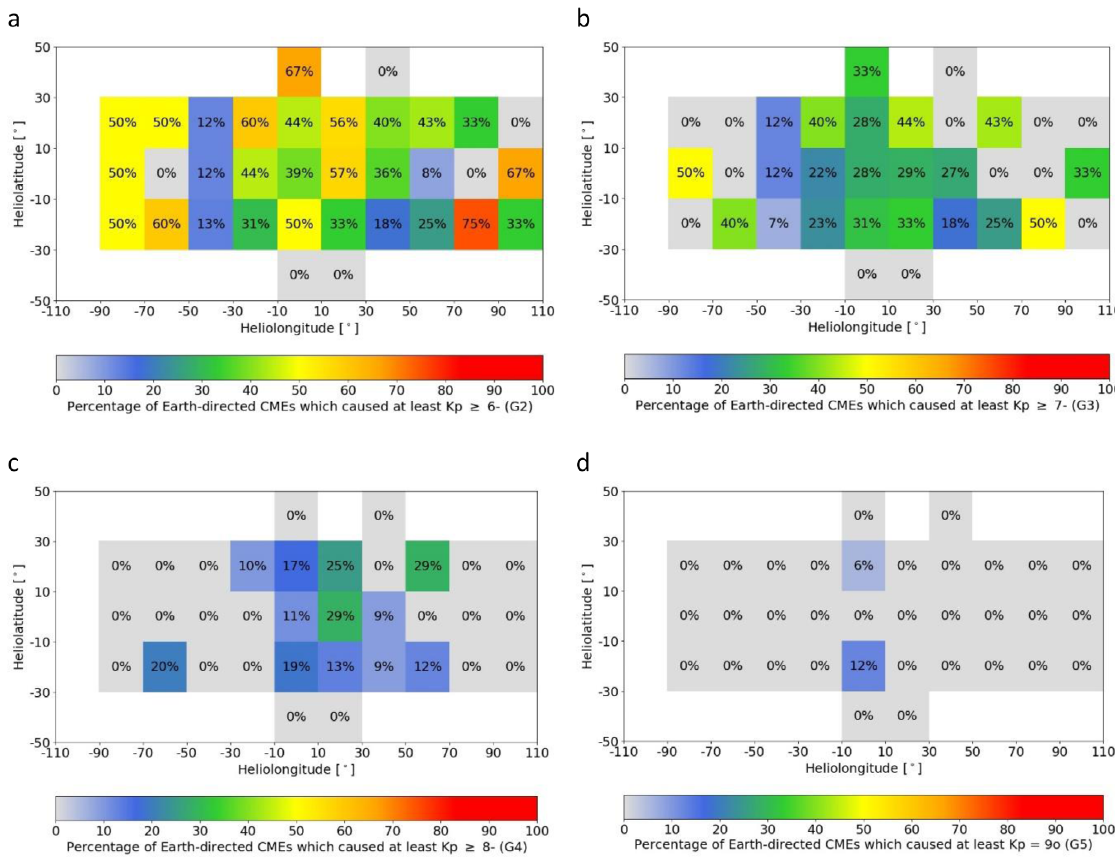
Fig. 5. Percentages of Earth-directed CME (total of 255) in January 1998 – December 2009, irrespective of speed (= summed over all speeds), binned by source region latitude and longitude, which caused storms with Kp (cid:5) 6 (cid:1) (a), Kp (cid:5) 7 (cid:1) (b), Kp (cid:5) 8 (cid:1) (c) and Kp = 9o (d).